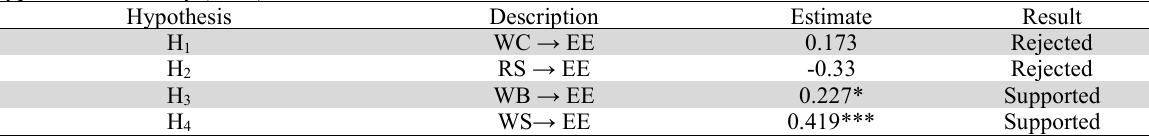
Hypotheses Summary